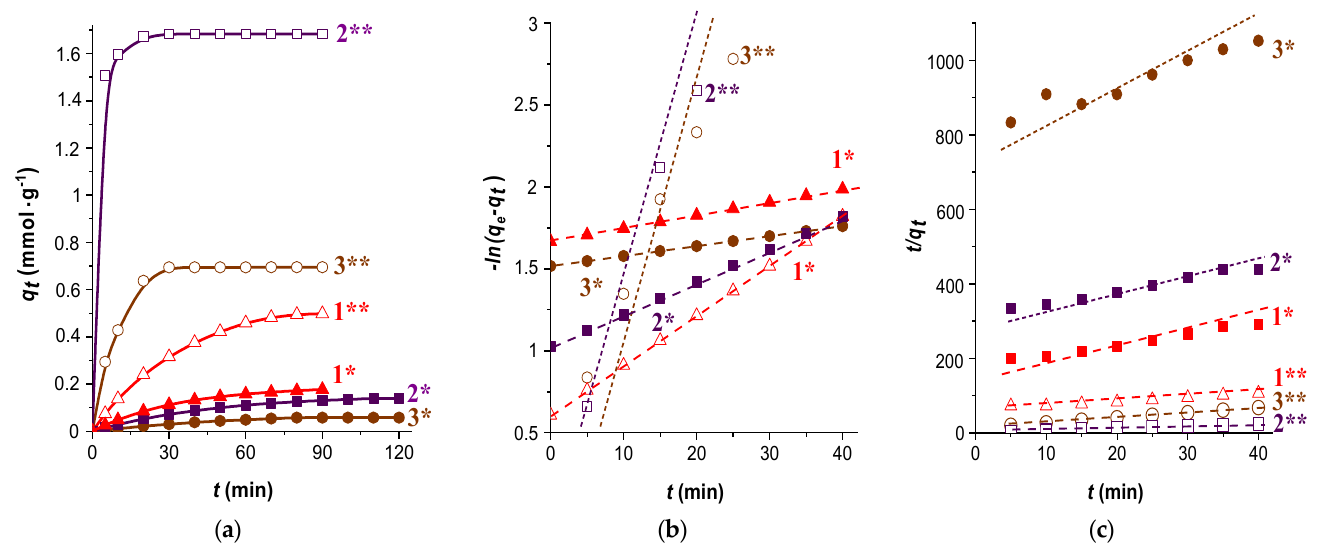
Figure 9. ( a ) Kinetics of theophylline adsorption by montmorillonite and bicomponent samples; ( b ) description by pseudo-first-order models; ( c ) description by pseudo-second-order models. 1 * and 1** are Mt at pH 2.0 and 5.0; 2 * and 2 ** are Р Rh –Mt (90:10) at pH 2.0 and 5.0; 3 * and 3 ** are P Ct –Mt (90:10) at pH 2.0 and 5.0.